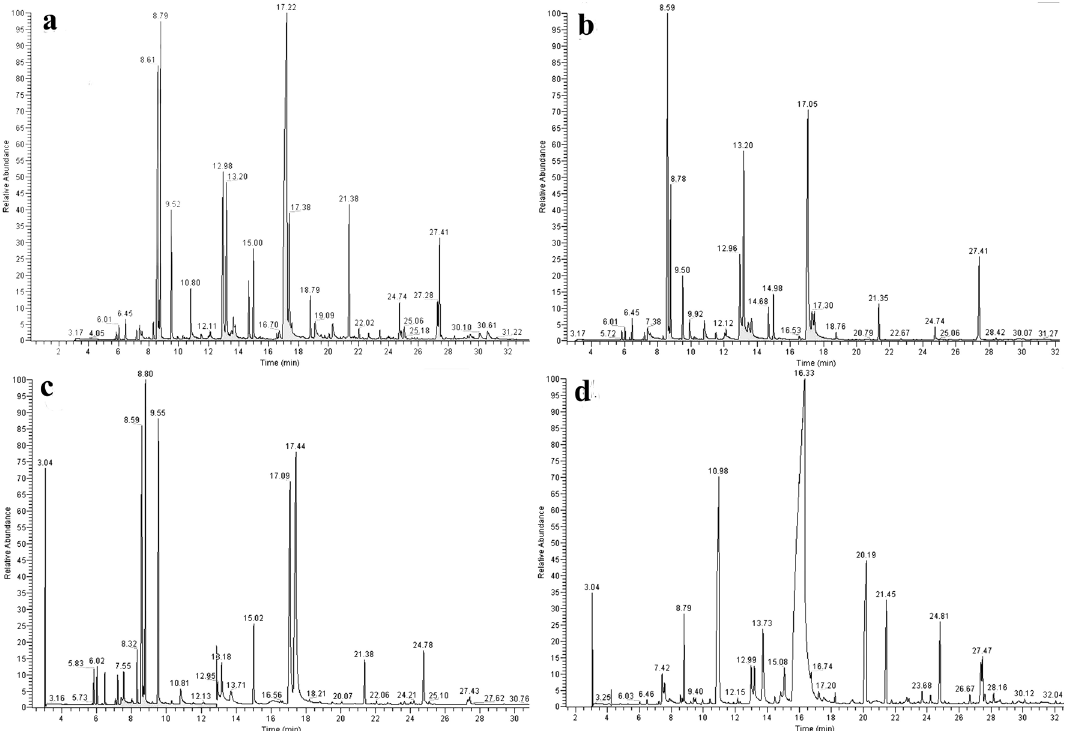
Figure 3. Total ion chromatograms (TICs) given by GC–MS of the YL-thyme oil ( a ), JB-thyme oil ( b ), QY-thyme oil ( c ) and LD-thyme oil ( d